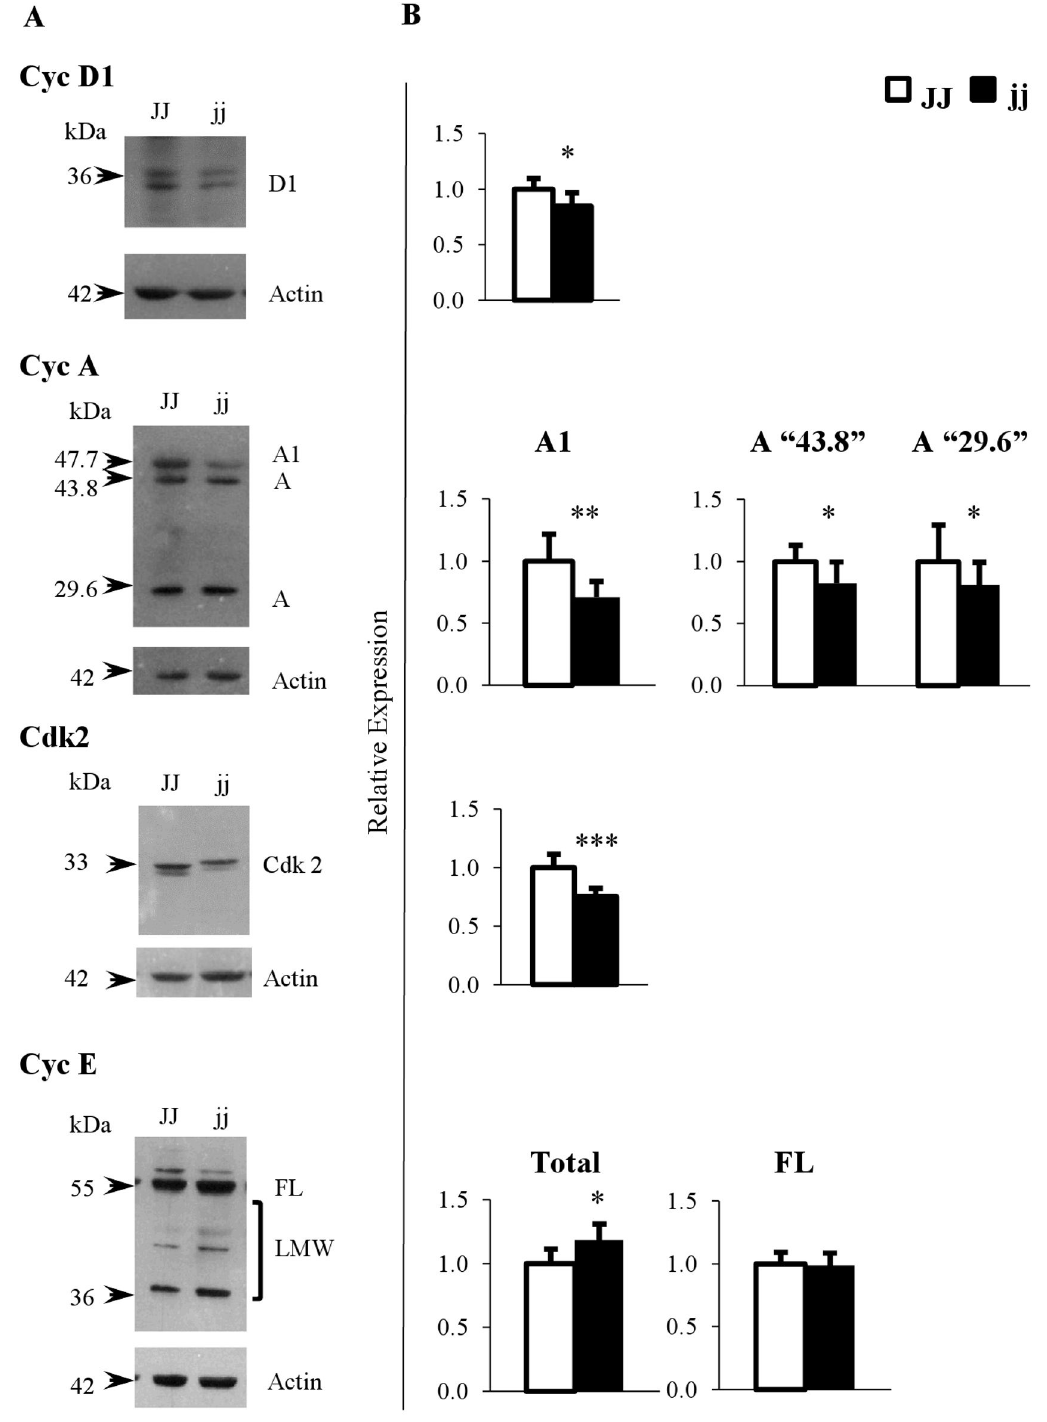
Figure 3. Representative Western blot and protein relative expression of Cyclin D1, Cyclin E, Cyclin A, A1 and Cdk2. A) Representative Western blot, and B) protein relative quantification. FL : full length Cyclin E (50 kDa), LWM : low molecular weight Cyclin E forms (49-34 kDa), Total : FL plus LMW Cyclin E forms. □ Normal homozygous JJ and ■ Hyperbilirubinemic homozygous jj Gunn rat. Data are expressed as mean ± SD. Statistical significance: * p < 0.05, ** p < 0.01, *** p < 0.001.